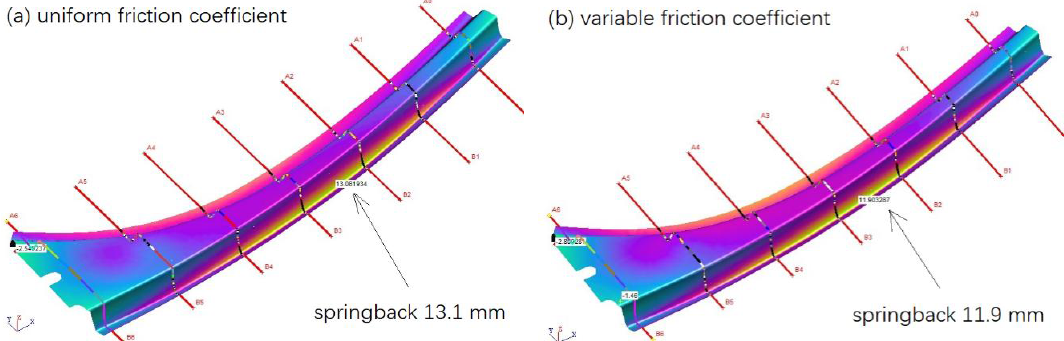
Figure 24. Simulated springback magnitude of the load beam: (a) conventional uniform friction coefficient model; (b) enhanced variable friction coefficient model.